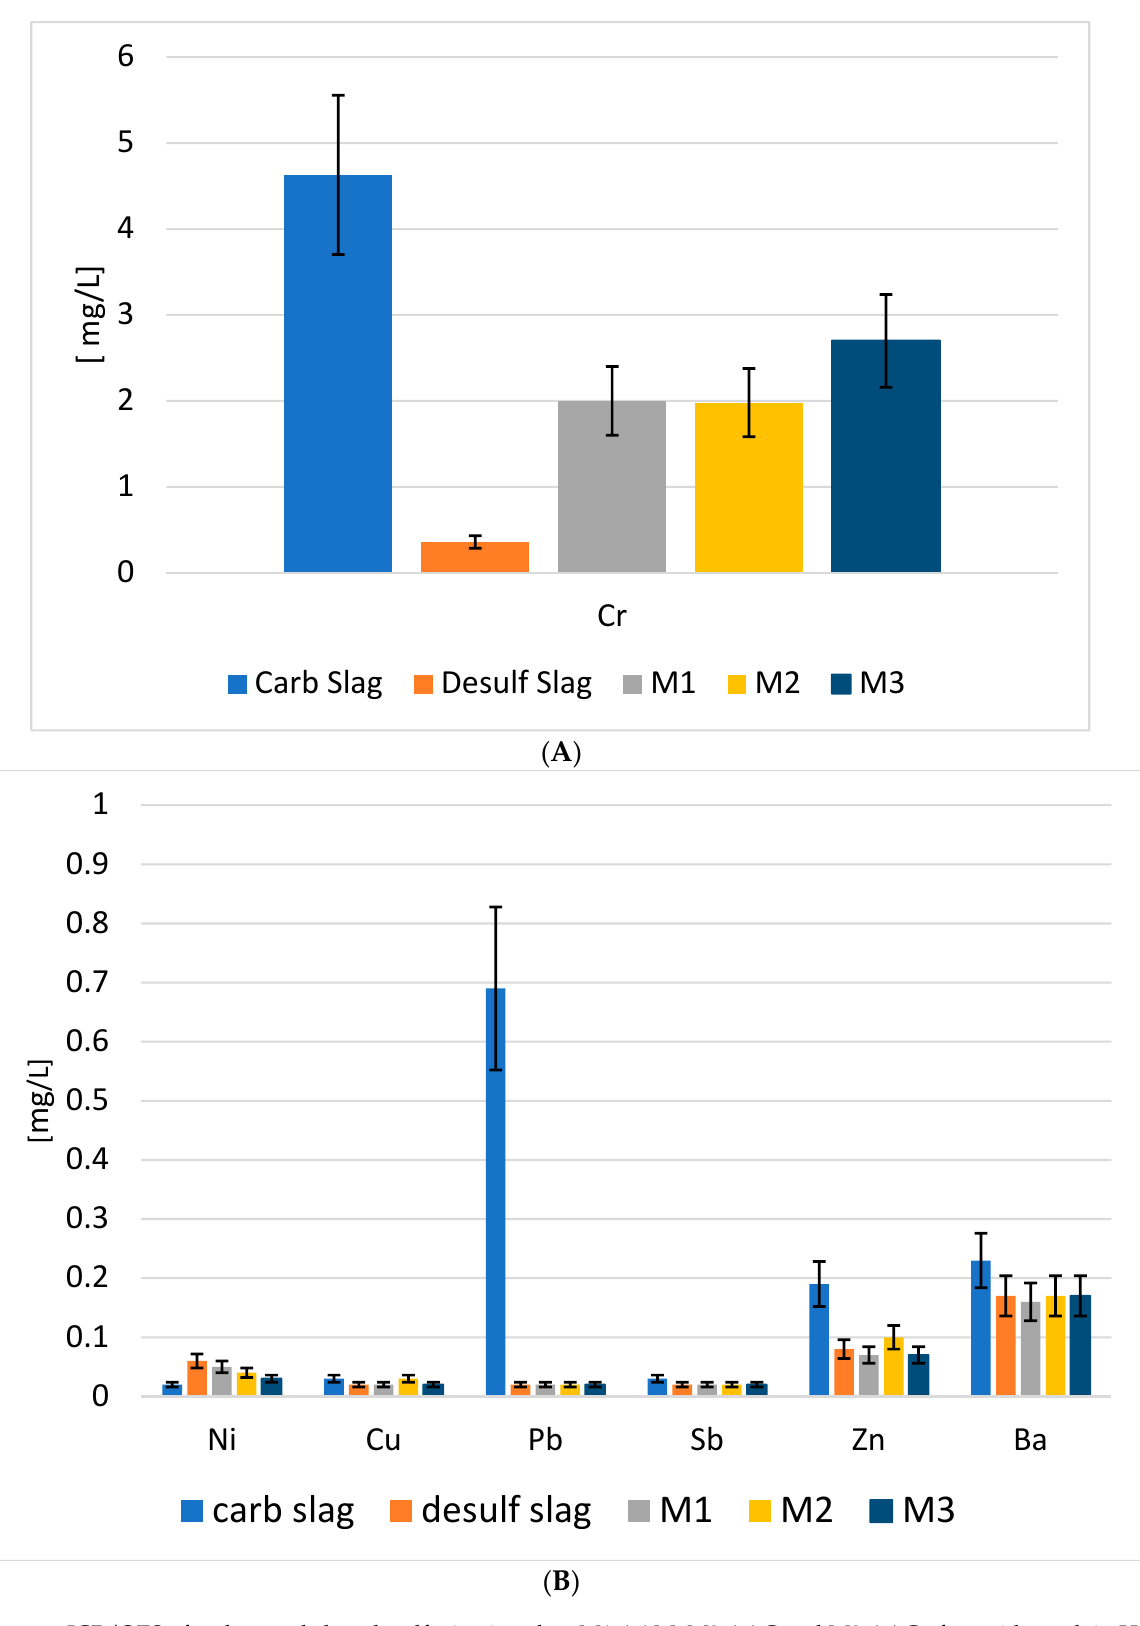
Figure 14. ICP/OES of carbonated slag, desulfurization slag, M1 AAM, M2 AAC and M3 AAC after acid attack in HCl solution ( A ) chromium, ( B ) other